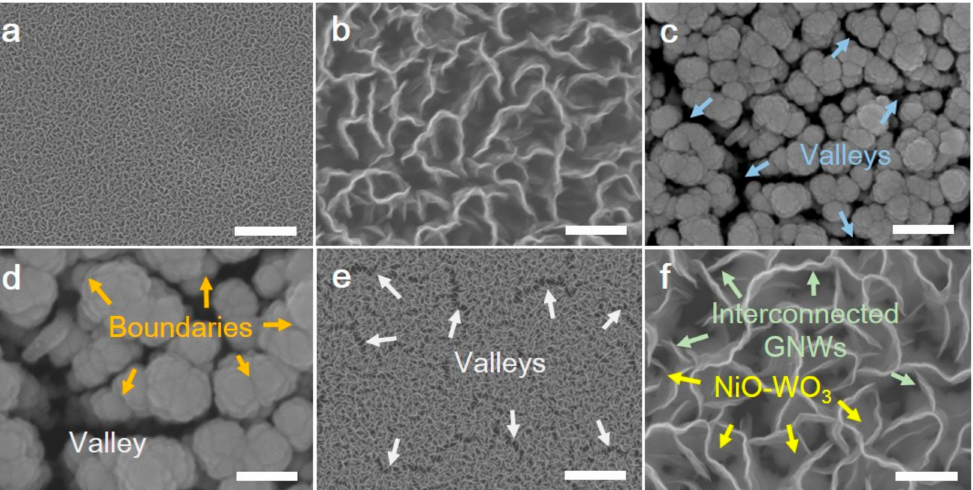
Figure 2. Morphology images of GNWs/NiO-WO 3 /GNWs heterostructure using FE-SEM analysis. ( a ) The morphological image of untreated GNWs (scale bar, 2 um). ( b ) The enlarged high-resolution morphology image of untreated GNWs (scale bar, 200 nm). ( c ) Co-sputtered NiO-WO 3 structure on GNWs (scale bar, 200 nm). ( d ) The enlarged high-resolution co-sputtered NiO-WO 3 structure with boundaries and valleys (scale bar, 100 nm). ( e ) The morphology of GNWs/NiO-WO 3 /GNWs with floating areas (scale bar, 2 um). ( f ) The enlarged high-resolution image of floating interconnected GNWs and NiO-WO 3 (scale bar, 200